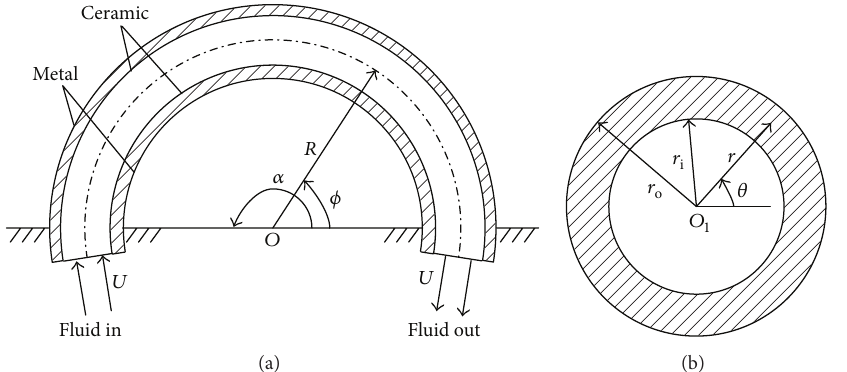
Figure 1: Mechanical model of a FGM curved pipe conveying fluid: (a) longitudinal-sectional view and (b) enlarged view of cross section.